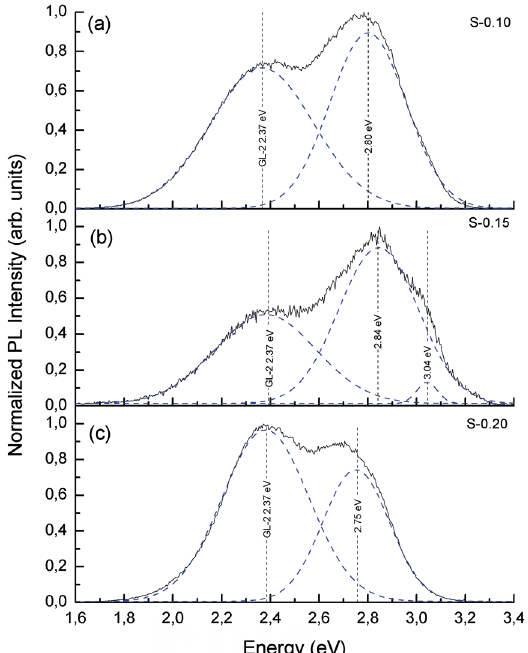
Figure 7. Normalized PL spectrum (black line) and its related deconvoluted bands (blue dash line) for samples: (a) S-0.10, (b) S-0.15 and (c) S-0.20. PL spectra of S-0.10 and S-0.15 are similar between them, which primary emission is related to β-Ga S-0.15 also has a low intensity emission band related to C-doped GaN at 3.04 eV. However, the primary emission band in S-0.15 PL spectrum is the GL-2, contrary to samples S-0.10 and